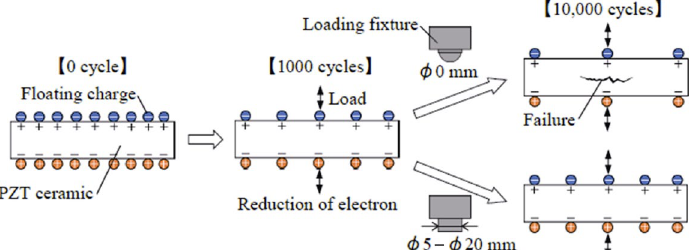
Fig. 15 Schematic diagram showing mechanism of electric-power generation and failure of PZT ceramic when cyclic loading is applied by ϕ 0 mm loading